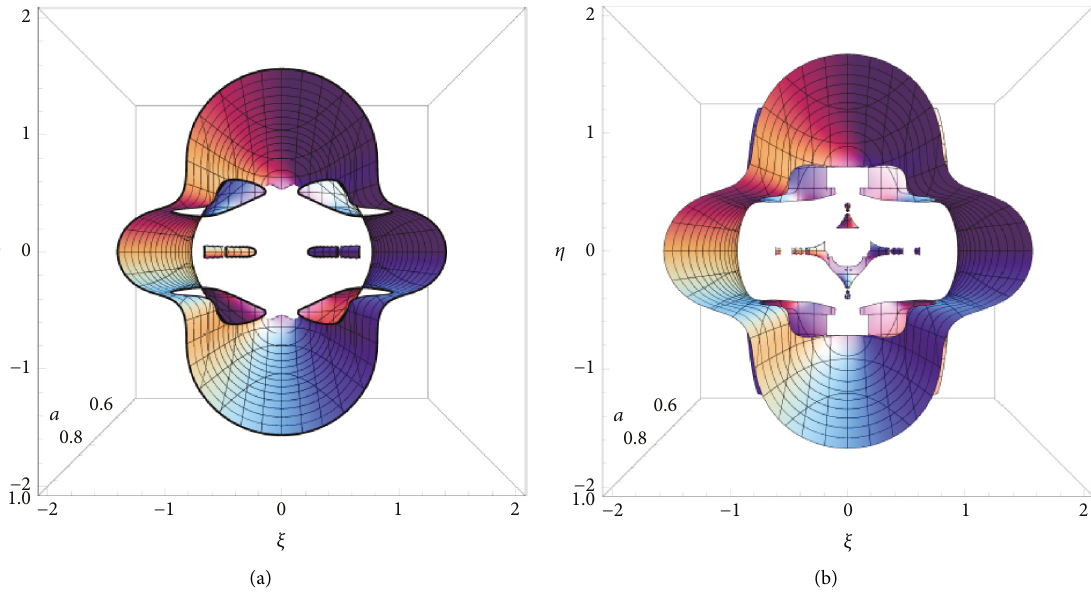
Figure 16: Projection of stability regions (a) b � 0 . 67 and 0 . 5 < a < 1; (b) b � 0 . 80 and 0 . 5 < a <